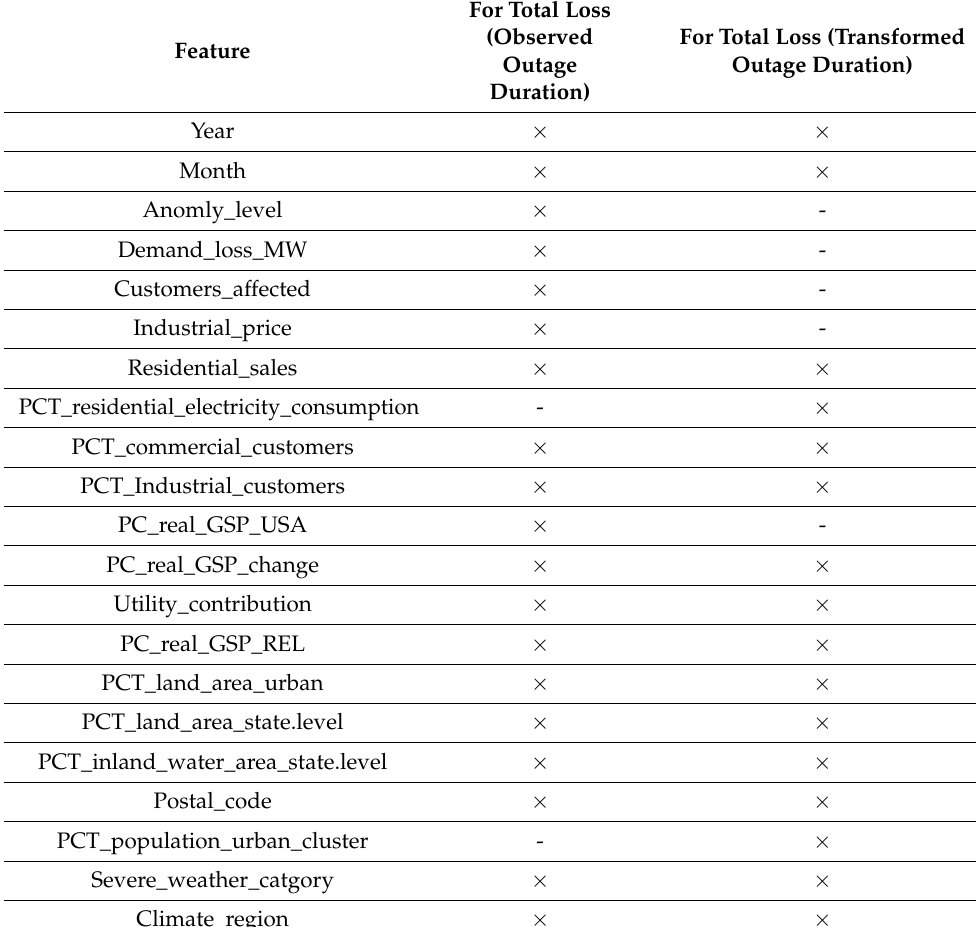
Table 3. Final set of features selected for prediction of revenue loss.